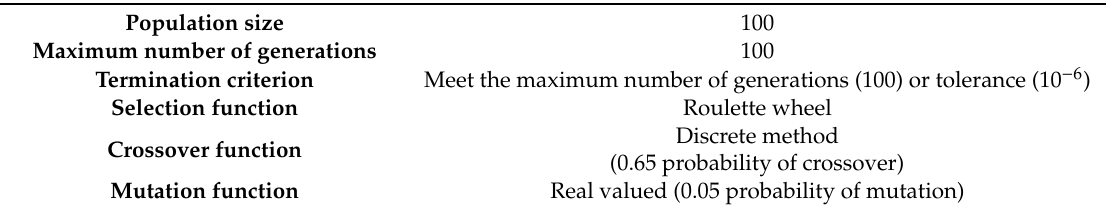
Table 6. Genetic algorithm (GA) structural